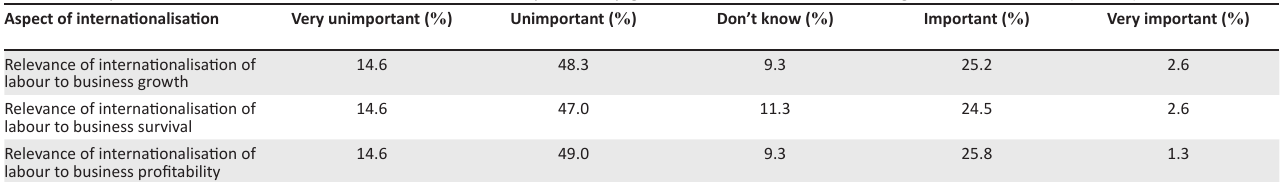
TABLE 6: Analysis of the influence of internationalisation of labour on profitability, growth and survival of small-scale agricultural businesses ( N = 151). Aspect of internationalisation Very unimportant ( % ) Unimportant ( % ) Don’t know ( % ) Important ( % ) Very important ( % )